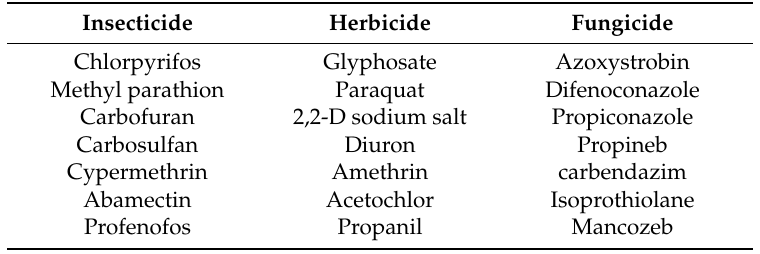
Table 3. The common pesticides used by the conventional farmers in this study. Insecticide Herbicide Fungicide Chlorpyrifos